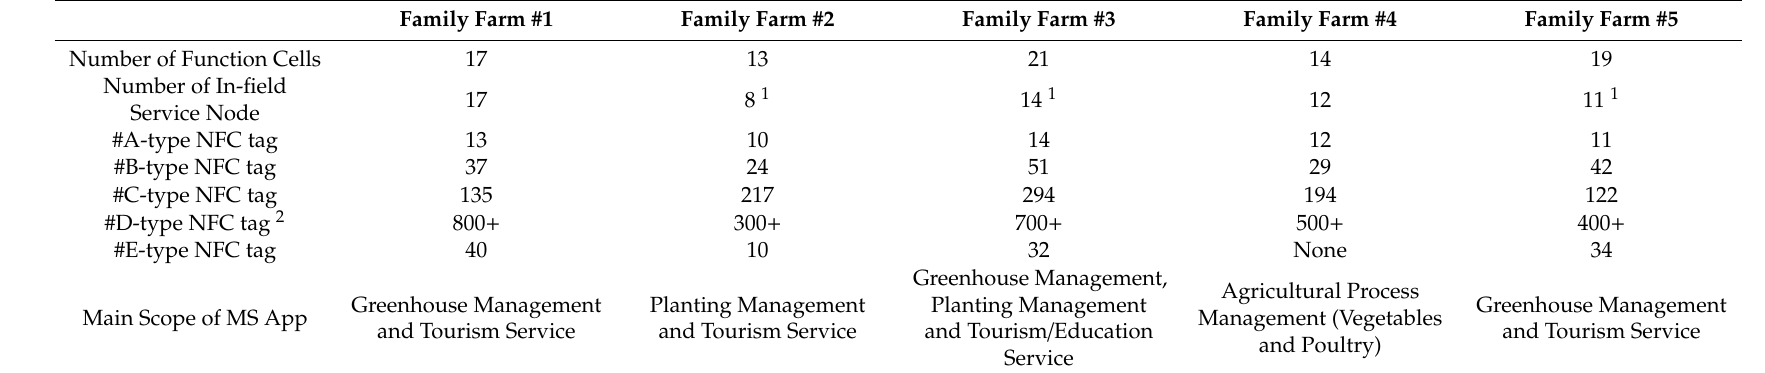
Table 2. The application of the proposed system in the family